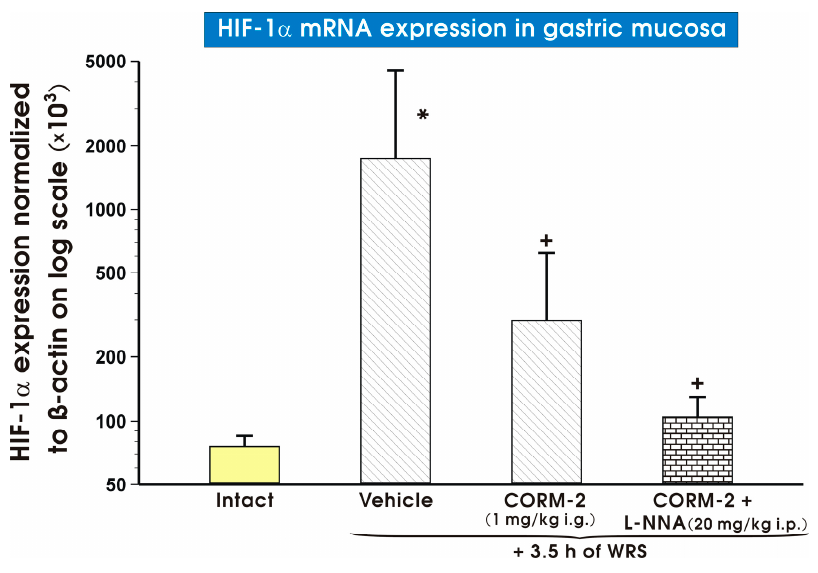
Figure 10. Expression levels of hypoxia inducible factor 1 α (HIF-1 α ) mRNA in the gastric mucosa of intact rats (yellow pattern) or those pretreated with vehicle (saline; i.g.; line pattern), carbon monoxide releasing molecule 2 (CORM-2, 1 mg/kg i.g.; line pattern) alone or in combination with N G -nitro- L -arginine ( L -NNA, 20 mg/kg i.p.; brick pattern) and exposed to 3.5 h of water immersion and restraint stress (WRS). Results are expressed as HIF-1 α mRNA expression normalized to β -actin.